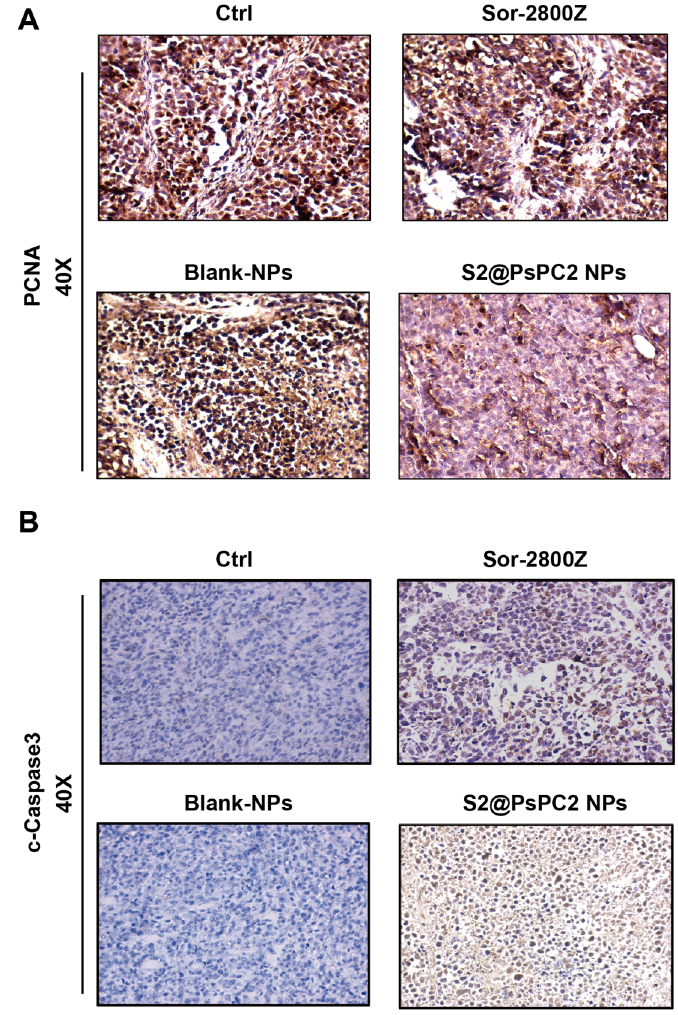
Figure 8. Representative IHC staining of PCNA ( A ) and cleaved-caspase3 (C-caspase) ( B ) in tumors of mice treated with control (PBS, Ctrl), blank NPs, free sorafenib and 2800Z combination (Sor-2800Z), or S2@PsPC2 NPs for 14 days. Images showed representative sections from five mice of each group.